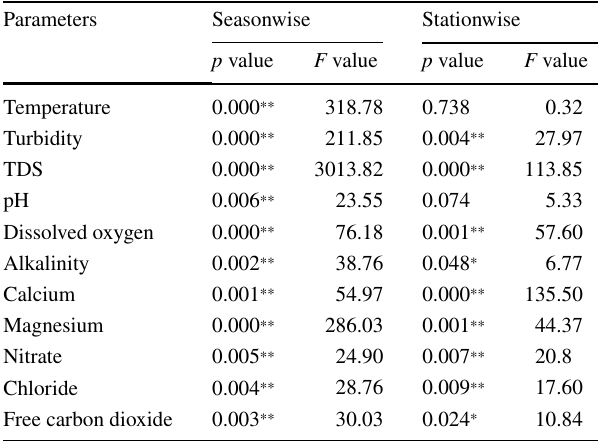
Table 2 Results of two-way ANOVA applied to a total of eleven physicochemical